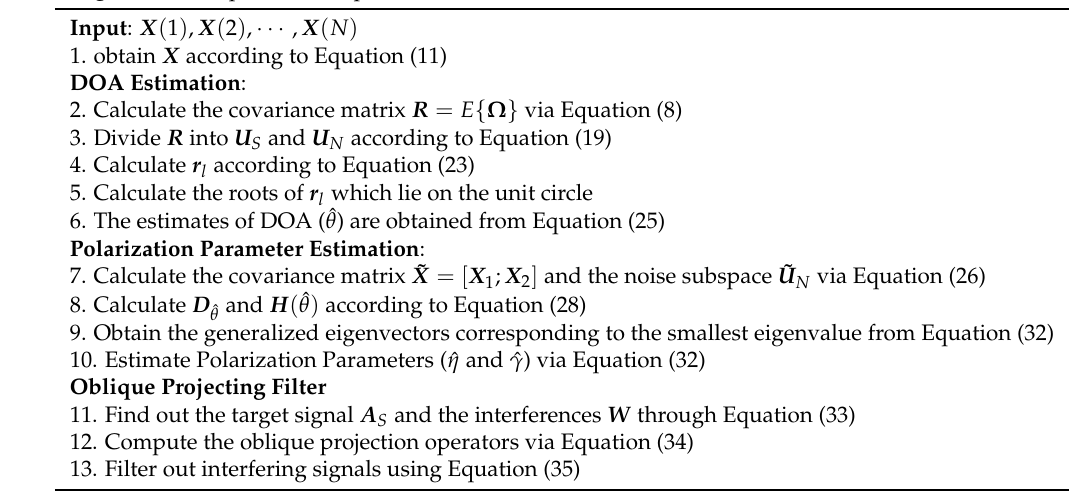
Algorithm 1 Steps in the Proposed Method